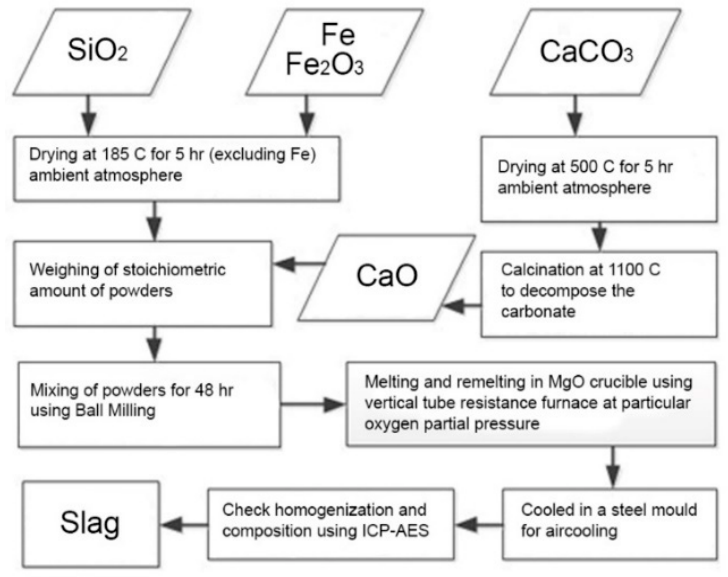
Figure 1. Master slag preparation procedure, melting carried out at 1300 °C and at p O 2 (oxygen partial pressure) of 10 − 8 atm.